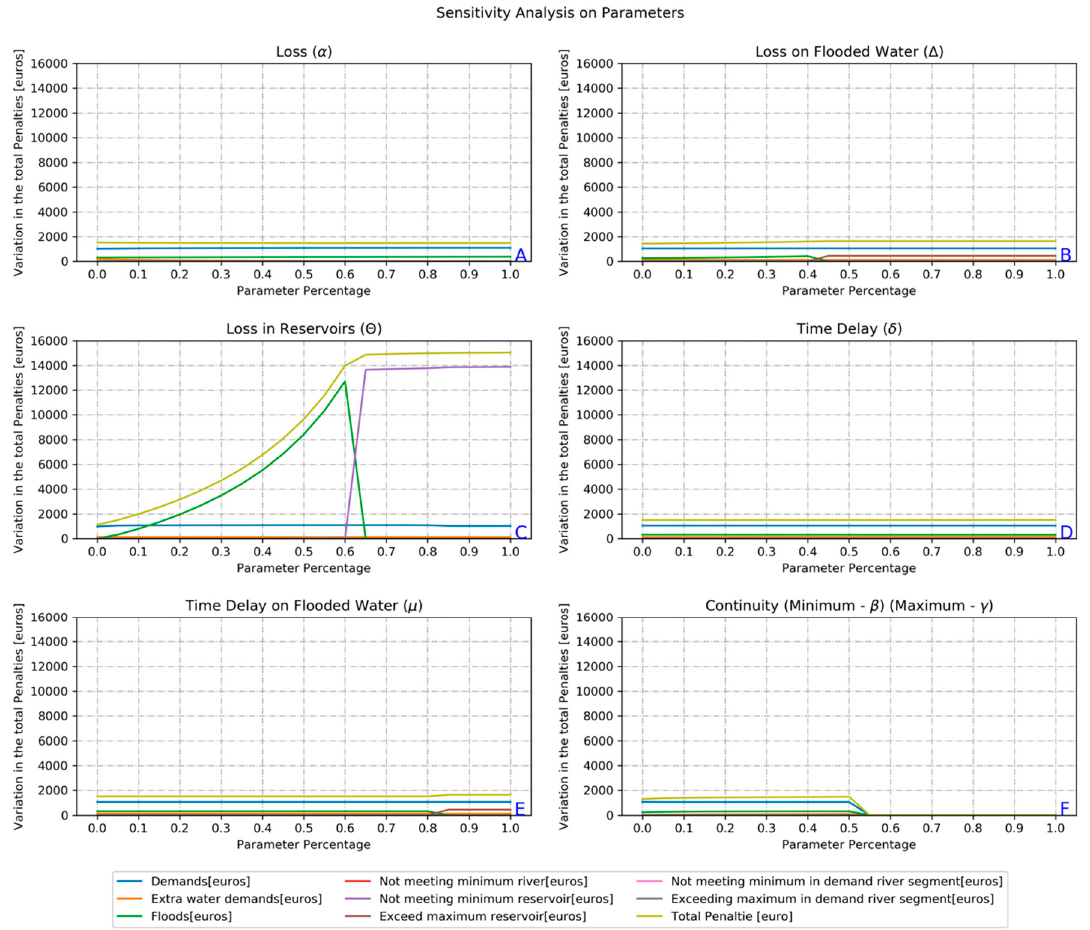
Figure 9. The sensitivity of the LP-model parameters.